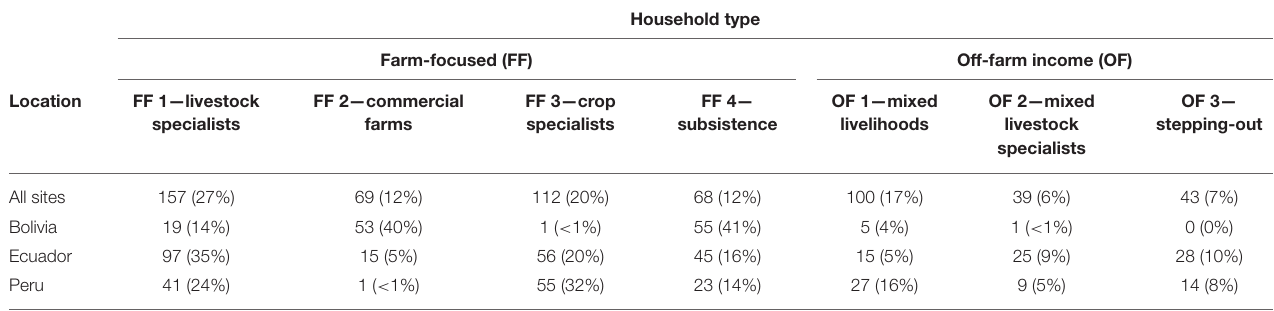
TABLE 2 | Number of rural household livelihood strategy types by country (followed by percentage in